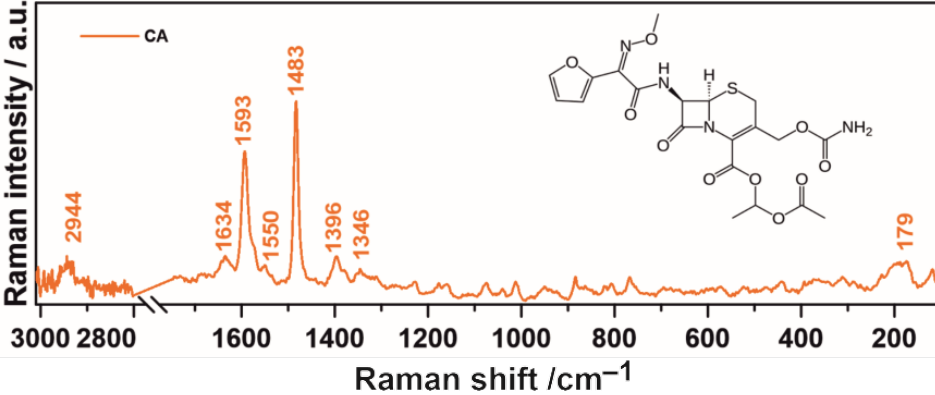
Figure 2. The Raman spectrum and the chemical structure of cefuroxime axetil. The spectra of α -, β -, γ - and 2HP- β -CDs (Figure 3) are also consistent with the literature data and allow for the undisputed identification of these compounds [43]. Briefly, the most important bands are those extending from 3000 to 2700 cm − 1 , describing the C–H stretching vibrational mode, bands ranging from 1500 to 1000 cm − 1 related mainly to the C–C and C–O stretching vibrations, bands in the 900 − 600 cm − 1 region, connected with bending modes of C–H bonds, and finally the bands in the 600–400 cm − 1 spectral range assigned to macrocyclic ring deformational modes [43]. Raman spectra of tablets containing complexes of all studied CDs with cefuroxime axetil are depicted in Figure 4. The predominant bands obtained in Raman spectra of examined samples and their attribution to specific chemical groups are summarized